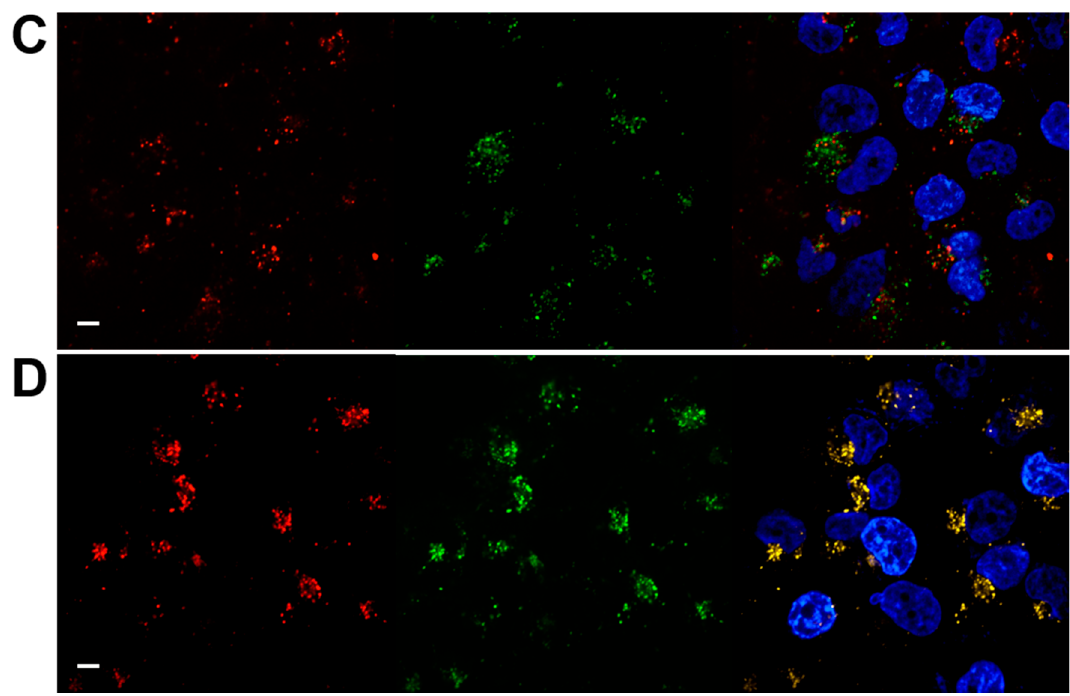
Figure 6. Representative images of intracellular distribution of Cy5-PHP and Cy5-TPGS in MCF-7/ADR cells from independently repeated experiments ( n = 3). Cells were incubated with Cy5-PHP ( A , B ) and Cy5-TPGS ( C , D ) for 30 min ( A , C ) and 4 h ( B , D ) at 37 °C, followed by treatment with lysotracker for 30 min. The first column is the images of Cy-5 labeled PHP and TPGS (red) in the cells. The middle column is the images of lysotracker (green). The last column is the merged images of nuclei (blue), lysosomes (green) and Cy5-PHP ( A , B )/Cy5-TPGS ( C , D ) (red). Scale bar = 11 μ m.